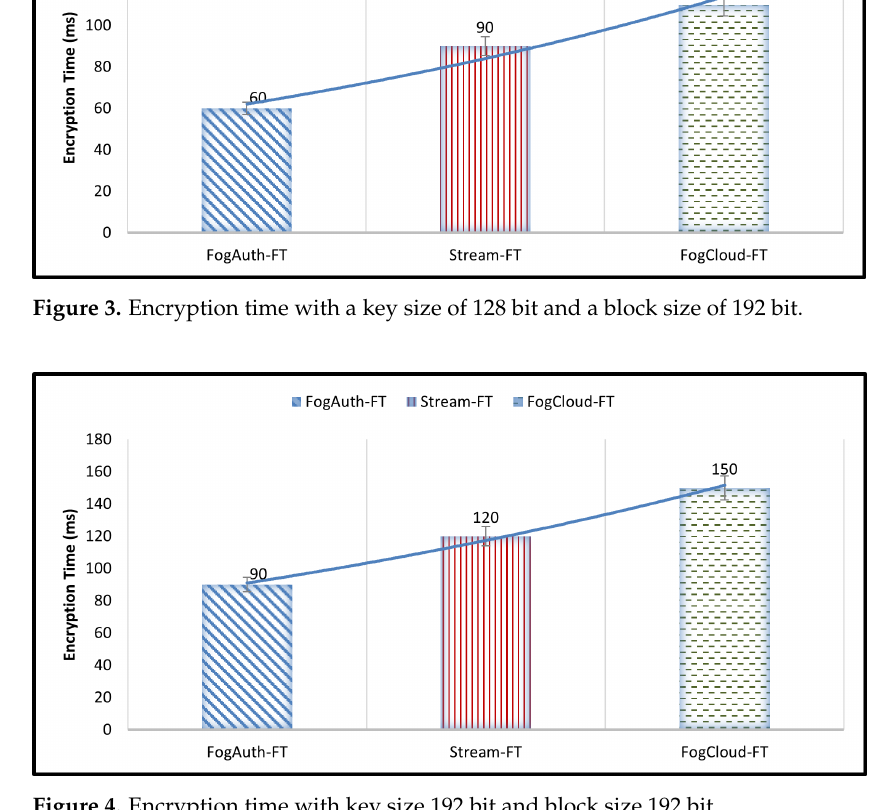
Figure 4. Encryption time with key size 192 bit and block size 192 bit.